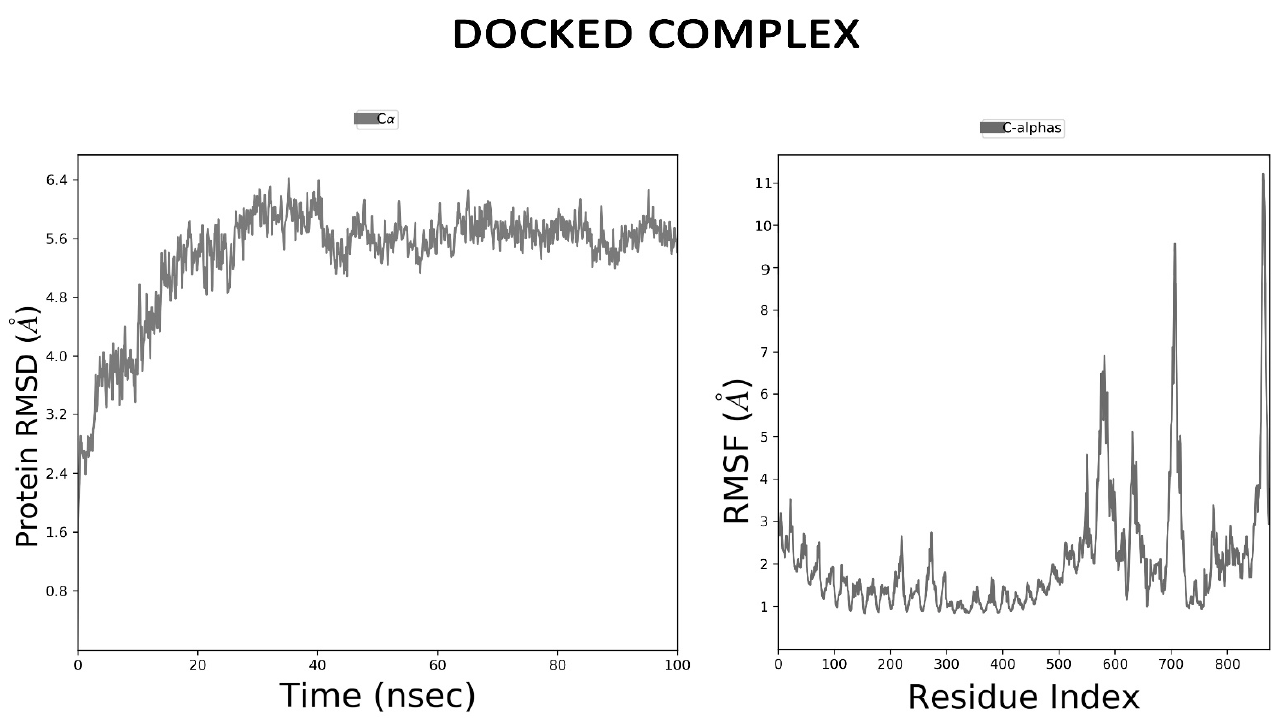
Figure 8. Root mean square deviation (RMSD) and root mean square fluctuation (RMSF) analysis of protein backbone and side chain residues of MD simulated vaccine construct.